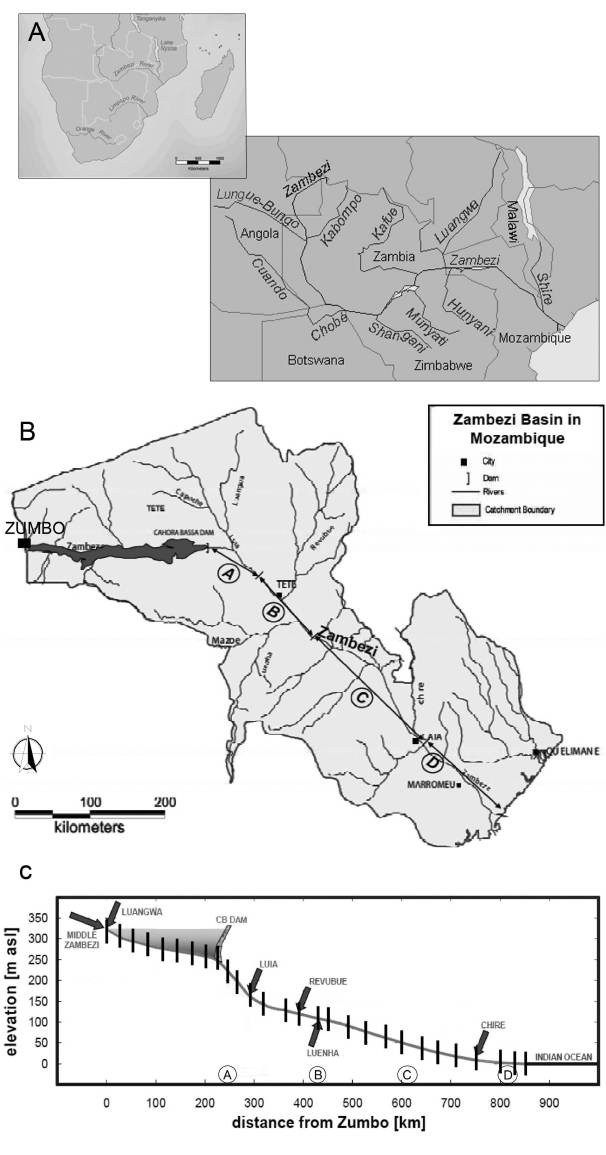
Figure 1. (A) Main African rivers’ basin, focus on the Zambezi River. (B) Lower Zambezi downstream the Cahora Bassa Dam. (C) Long profile of the main channel and principle tributaries of the lower reach (adapted from Ronco et al.,